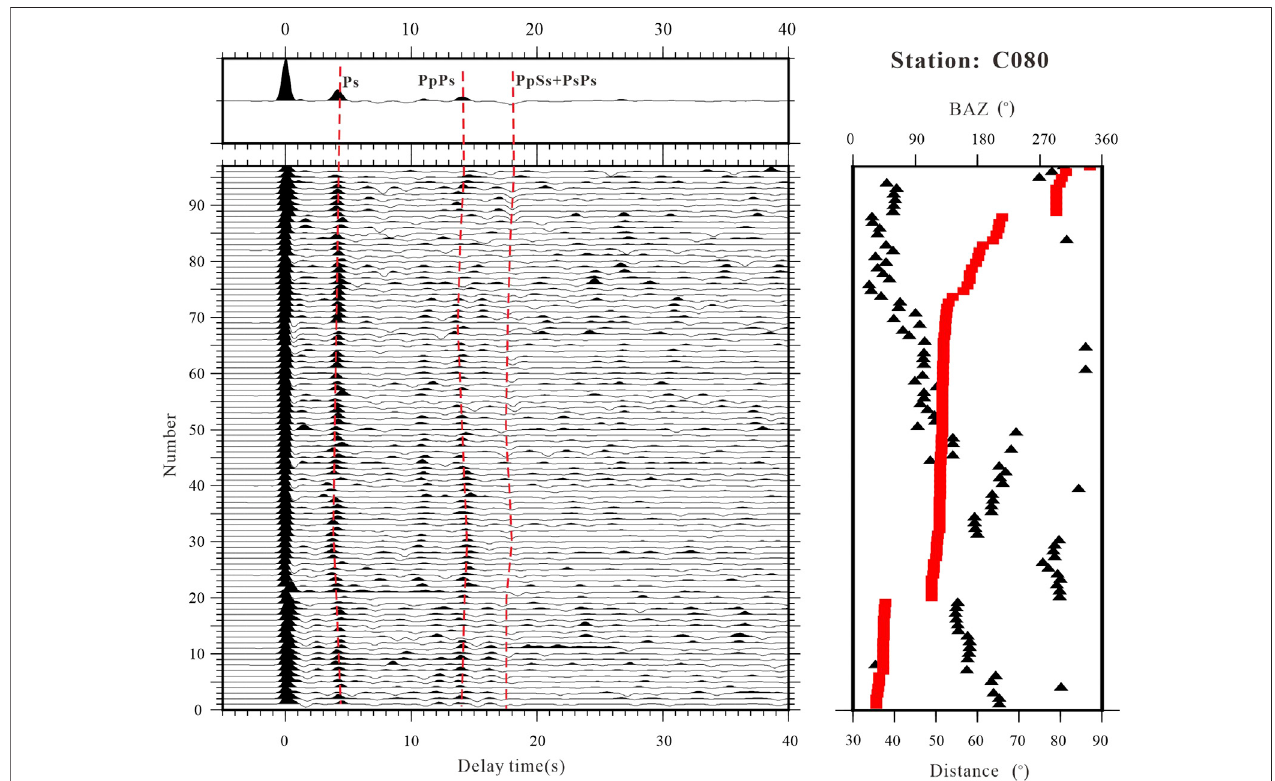
FIGURE 2 | Receiver function records from station C080: (left) receiver functions arranged according to back-azimuth, where the numbers on the axis denote the latencytimeofPwavearrival.Theresultsofthelinearsuperpositionreceiverfunctionsareshownatthetopoftheleft fi gure.Theseismicphases(Ps,PpPs,PpSs+PsPs) are marked by red and broken lines. Red rectangles represent the back-azimuth in the fi gure on the right, and the black triangles denote epicenter distance distribution.